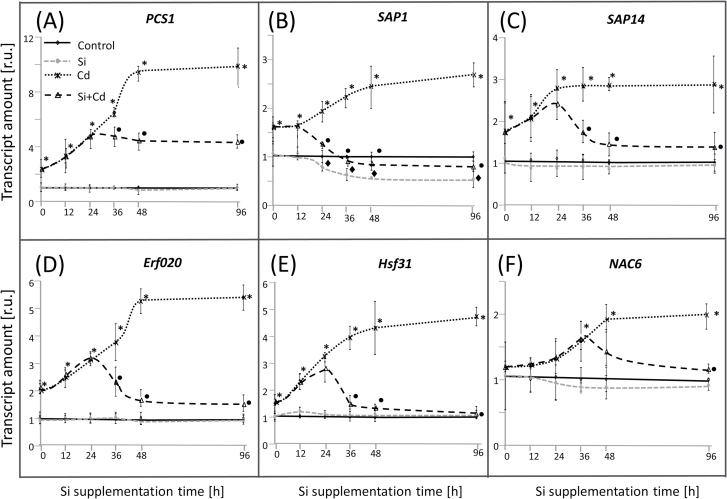
Time course analysis of transcript regulation for selected targets in roots of control and Si-supplied rice plants with or without Cd exposure. mRNA levels were quantified by qPCR from three independent experiments with duplicate determinations. Data are means ±SD, asterisks denote significant differences between Cd-treated and control rice, filled circles indicate a significant difference between Cd/Si-treated and Cd-treated plants, and filled diamonds mark significant differences between Si-treated and control plants. Student’s t-test, P<0.05.